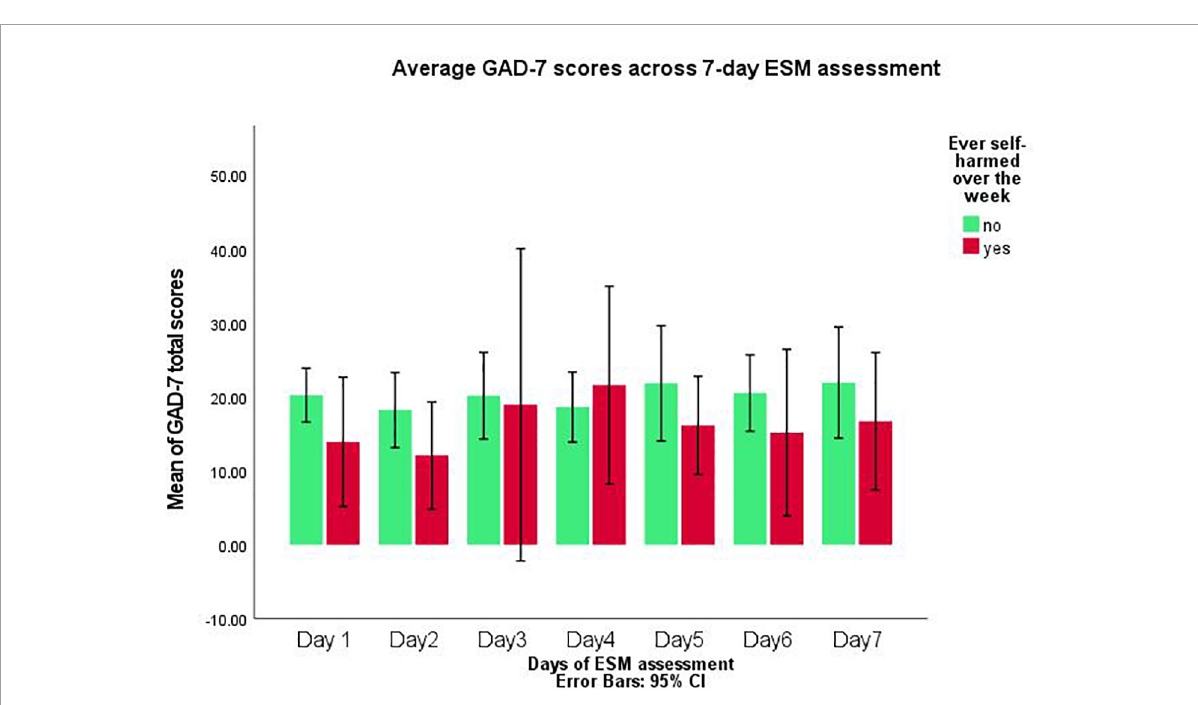
FIGURE3 GAD-7 scores compared between participant who self-harmed and those who did not during 7-day experience sampling method (ESM)